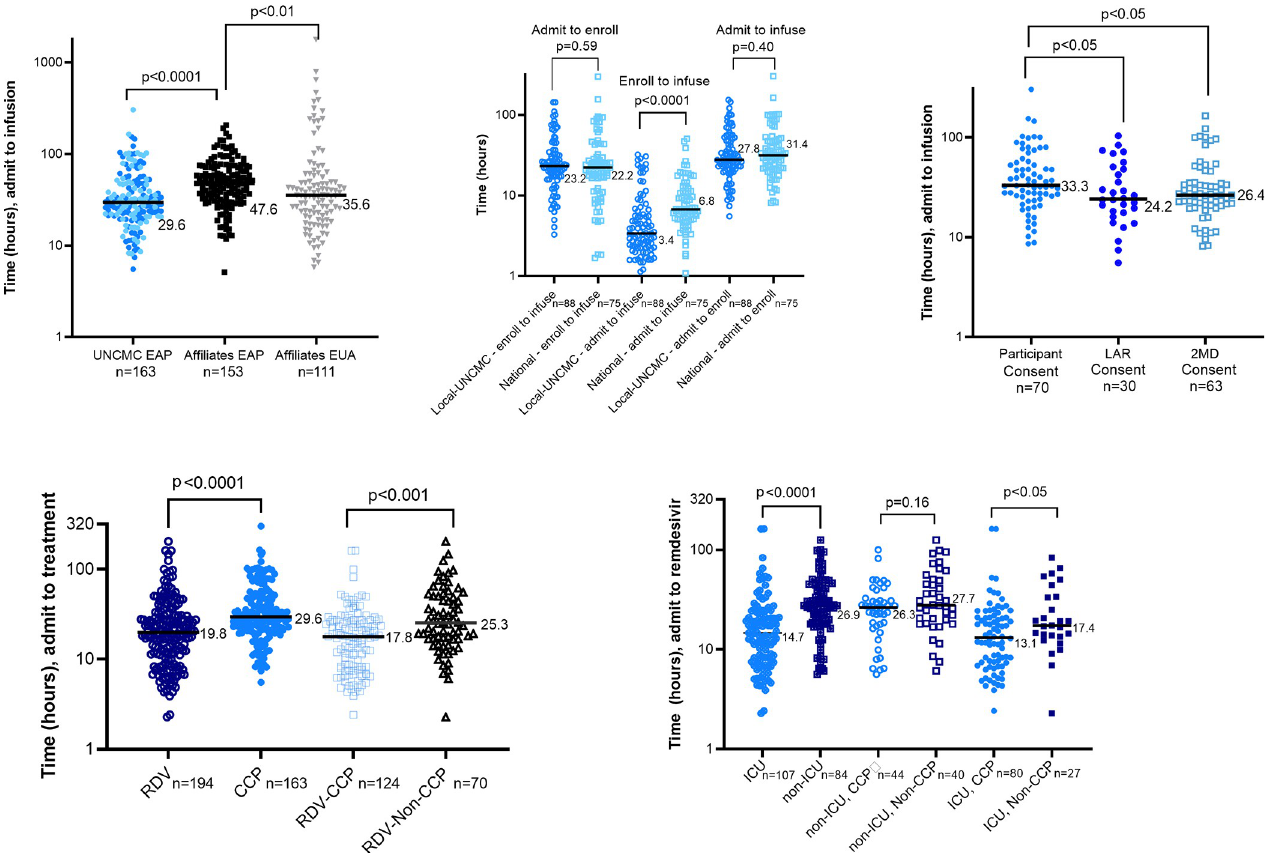
Fig 2. Time to CCP infusion comparisons. (A) Time from admission to CCP infusion of recipients in the UNCMC EAP (blue circles) versus affiliates EAP (black squares) versus affiliates EUA (grey inverted triangles). (B) Time from admission to enrollment, enrollment to CCP infusion and admission to CCP infusion for recipients in the UNCMC EAP comparing those that received CCP units from the UNCMC Blood Donation Center (dark blue open circles) versus a national vendor (light blue open squares). (C) Time from admission to CCP infusion for type of EAP consent obtained at UNCMC (participant consent in light blue circles, LAR consent in dark blue circles, 2MD in open squares). (D) During the CCP EAP era at UNCMC, first comparison is time from admission to remdesivir for all who received remdesivir (dark blue open circles) versus time from admission to CCP infusion of EAP participants (middle blue circles); second comparison is time from admission to remdesivir for all who received remdesivir and CCP (light blue open squares) versus those who received only remdesivir (black open triangles). (E) During the CCP EAP era at UNCMC, time from admission to remdesivir: first comparison is between those that received remdesivir in the ICU (middle blue circles) versus non-ICU (dark blue squares); second comparison is between those that received remdesivir and CCP (middle blue open circles) versus only remdesivir in the non-ICU (dark blue open squares); third comparison is between those that received remdesivir and CCP (middle blue circles) versus only remdesivir in the ICU (dark blue squares). Medians are reported. P values obtained via a non-parametric Mann-Whitney U